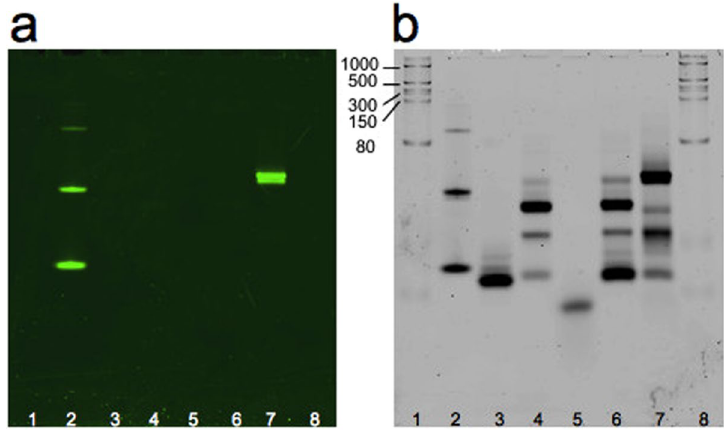
Figure 4. 10% TBE gel electrophoresis after DFHBI-1T ( a ) and SYBR ® Gold ( b ) staining. The gel was stained with fluorophore DFHBI-1T for 20 min to visualize the Broccoli aptamer and the assembly of Split1, Split2 and complementary Split1/Split2 De Bruijn sequence. After 3 washing steps, the gel was stained with SYBR ® Gold for 10 min to detect nucleic acids. Lanes: 1, 8: ssRNA ladder; 2: Broccoli aptamer; 3: Split1; 4: Split2; 5: complementary Split1/Split2 De Bruijn sequence; 6: Split1 and Split2 after incubation at 37 °C for 25 min; 7: Split1, Split2 and complementary Split1/Split2 De Bruijn sequence after incubation at 37 °C for 25 min. Molecular sizes in nucleotides are indicated.